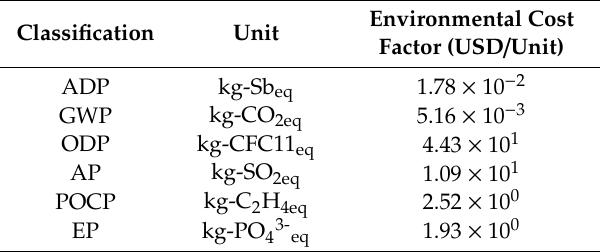
Table 5. Environmental Cost